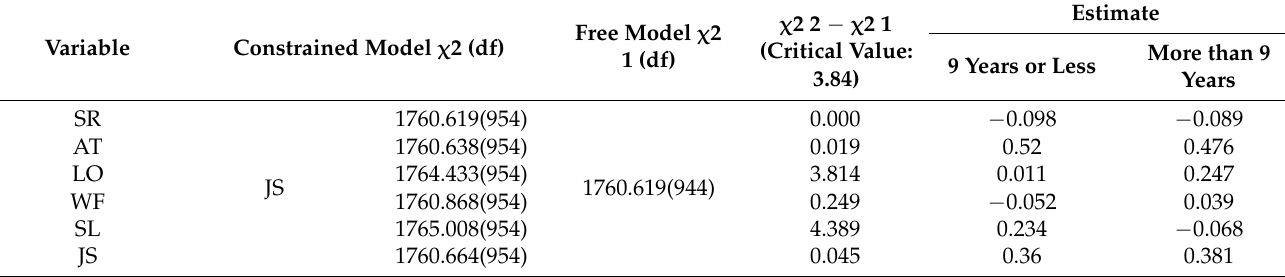
Table 6. Results of the moderation effect